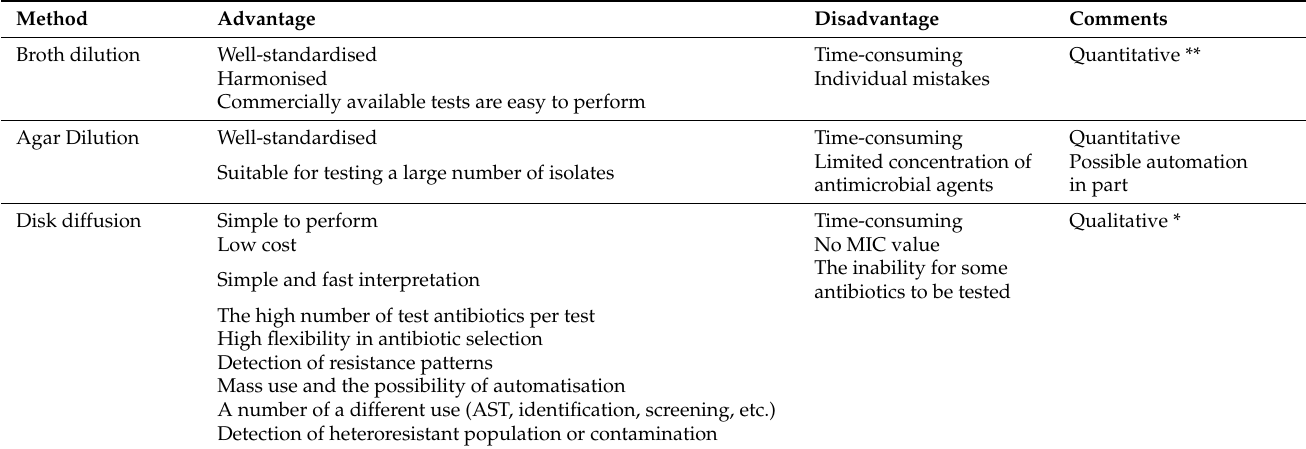
Table 1. Advantages and disadvantages of the common methods of antimicrobial susceptibility